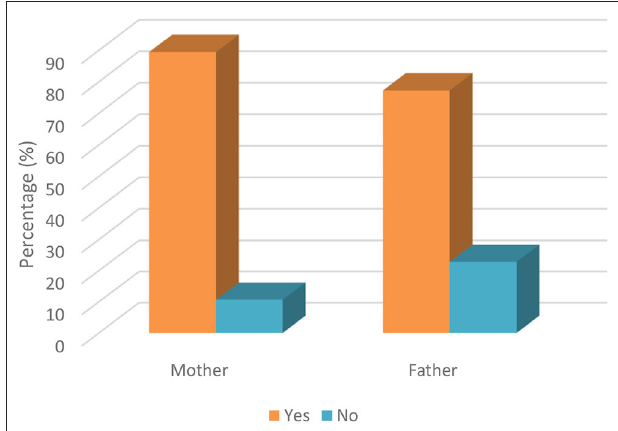
FIGURE 1 | Knowledge of parents’ about COVID-19 transmission by air droplets during dental treatment based on parenthood relationship.